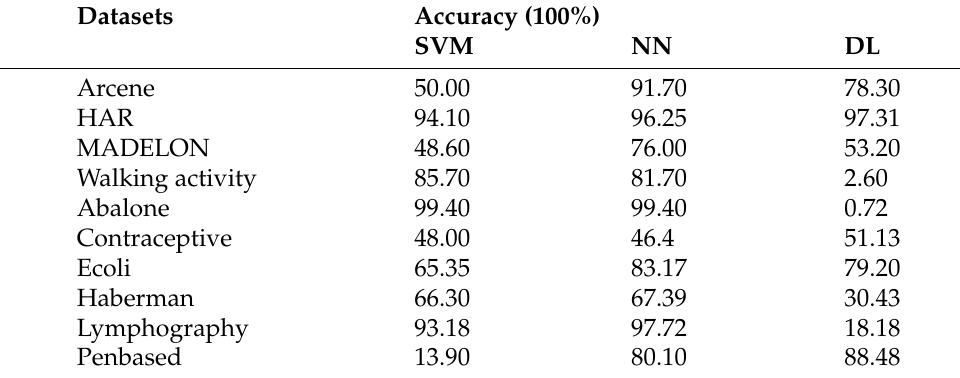
Table 7. Accuracy rates between SVM, NN and